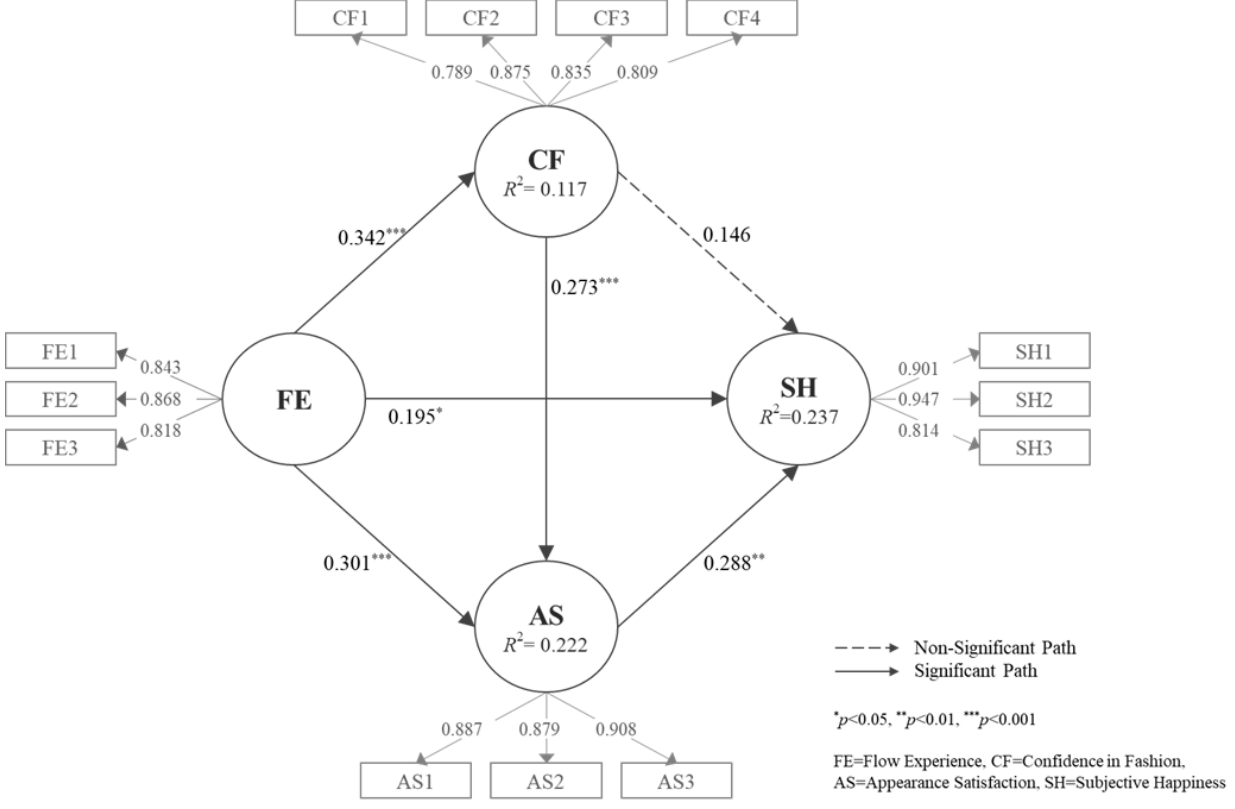
Figure 2. Results of structural equation modeling